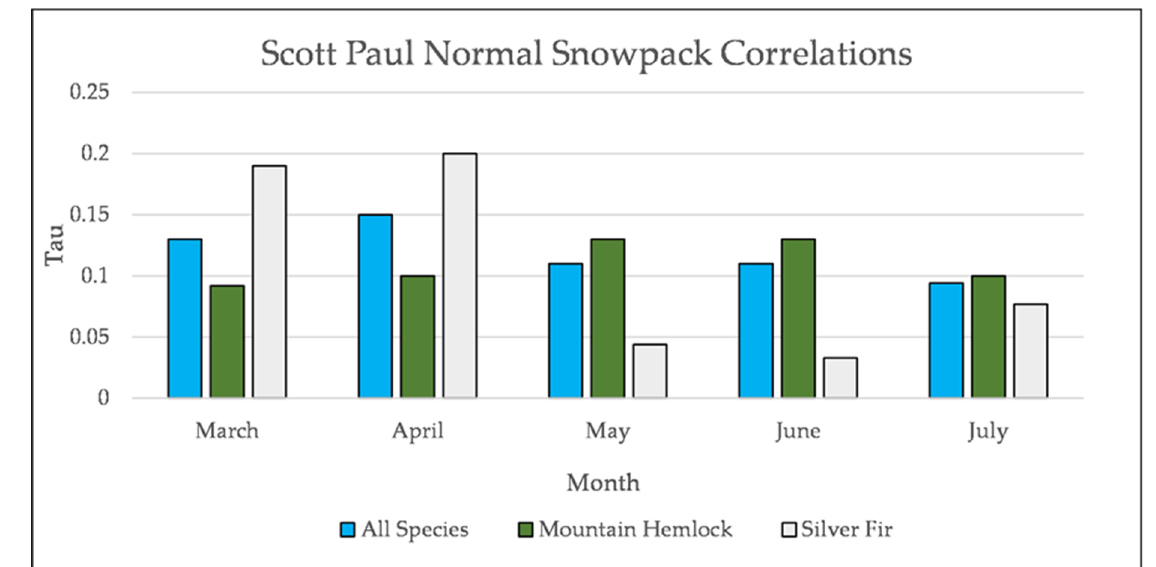
Figure A23. Normal Kendall’s correlation between mean monthly precipitation and establishment at the Grouse Ridge site. * = p -Value < 0.05.